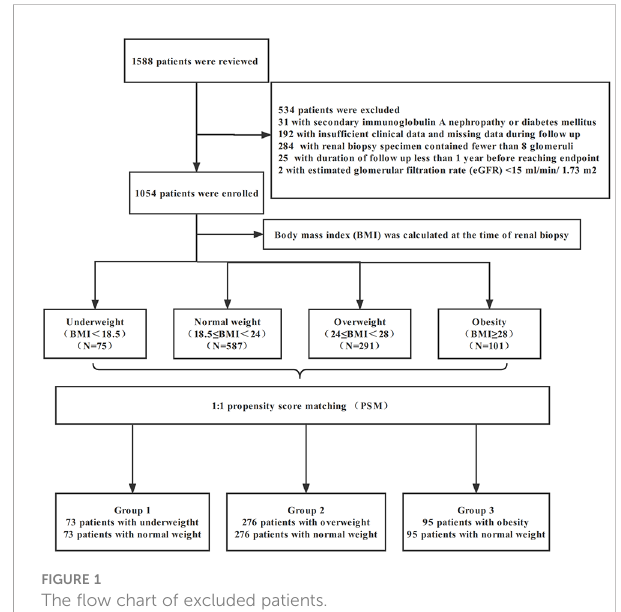
FIGURE 1 The fl ow chart of excluded